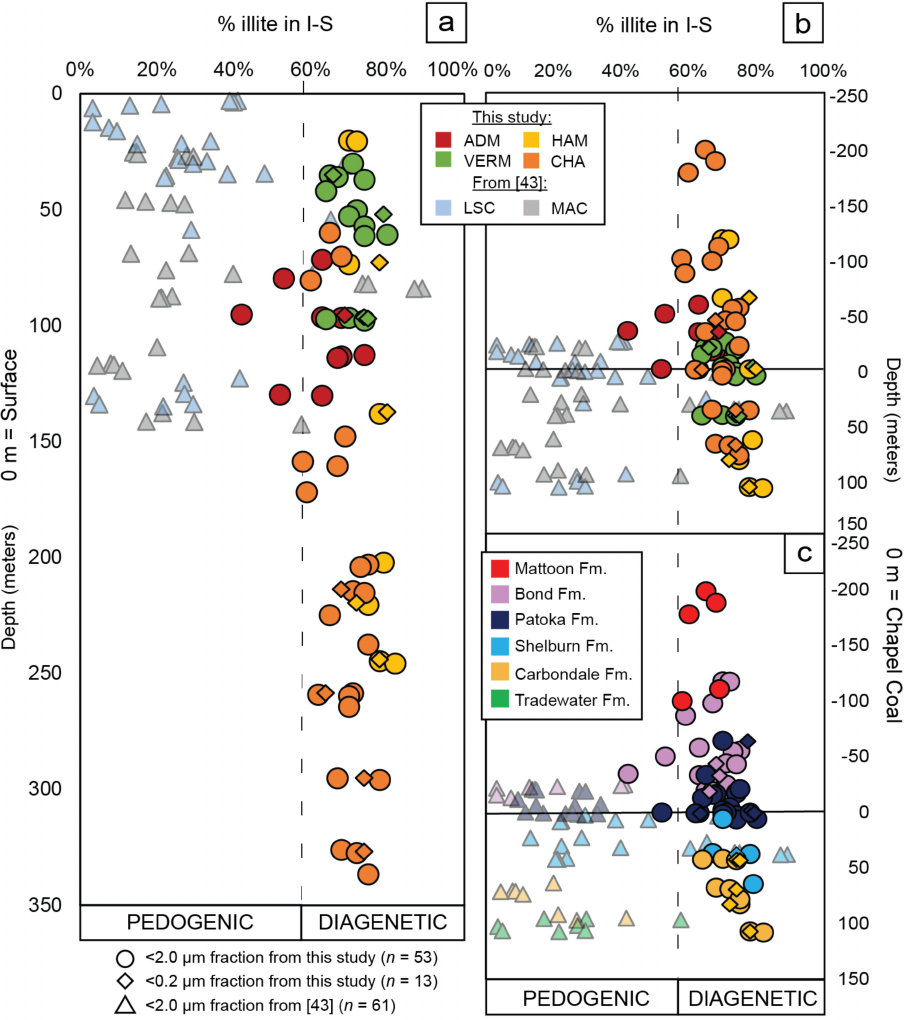
Figure 9. ∆ ◦ 2 θ values were calculated from Equation (1) and converted to % illite in illite-smectite superstructures [1] for each <2.0 µ m (circles, this study; triangles from [43]) and <0.2 µ m (diamonds, this study) clay-sized fraction of paleosol samples taken from the Materials Service Corps #F-72-8 (VERM; green; <2.0 µ m, n = 13; <0.2 µ m, n = 4), Illinois State Geological Survey (ISGS)-Archer-Daniels-Midland, Borehole MMV-04B (ADM; red; <2.0 µ m n = 10; <0.2 µ m, n = 1), ISGS #1 City of Charleston (CHA; orange; <2.0 µ m, n = 22; <0.2 µ m, n = 4), the American Coal Company Borehole 7510-20 (HAM; yellow; <2.0 µ m, n = 8; <0.2 µ m, n = 4), the Lone Star Cement Company #TH-1 (LSC; blue; <2.0 µ m, n = 32 [43]), and the Monterey Coal Company, Mac 1 #CBM4 (MAC; grey; <2.0 µ m, n = 31 [43]) cores. Samples that have <60% illite in I-S are interpreted to result from pedogenic illitization [27], whereas samples >60% are interpreted to result from diagenetic illitization [7]. See Tables 2 and 3 for tabulated data. ( a ) % illite in I-S relative to depth form the surface, where 0 m represents the top of each core. Each core is color coded to the map in Figure 2b. ( b ) % illite in I-S is plotted relative to stratigraphic position in the basin, where the 0 m datum is equivalent to the location of the Chapel Coal in each core. The Chapel Coal, of the lowermost Patoka Fm (Figure 2a) is shown as stratigraphic data to the depth measurements. Each data point color follows the legend in part a. ( c ) This is the same plot as part b, except each sample point is color coded towards the formation from which it was sampled, including: the Mattoon (red; <2.0 µ m, n = 5), Bond (lilac; <2.0 µ m, n = 26; <0.2 µ m, n = 3), Patoka (navy; <2.0 µ m , n = 35; <0.2 µ m, n = 4), Shelburn (turquoise; <2.0 µ m, n = 25; <0.2 µ m, n = 1), Carbondale (ochre; <2.0 µ m, n = 17; <0.2 µ m, n = 5), and Tradewater Formations (green; <2.0 µ m, n =